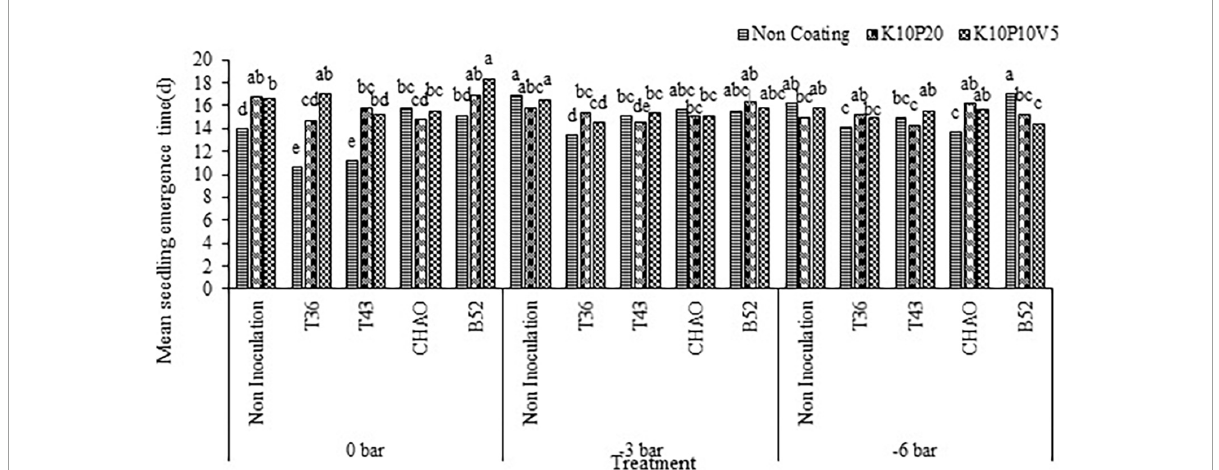
FIGURE7 Interaction of mean seedling emergence time (d) of cumin affected by inoculation + coating at different levels of drought stress. Means with the same letter are not significantly different according to the HSD test at P = 0.05. CHA0, B52 of Pseudomonas fluorescens , T36 and T43 of Trichoderma harzianum isolates. K, kaolin; V, vermiculite; P, perlite.